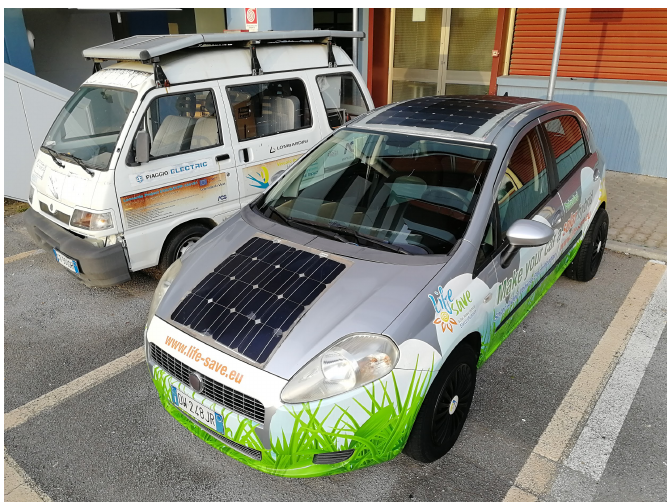
Figure 3. Hybrid Solar Vehicle prototype realized by University of Salerno on a FIAT Grande